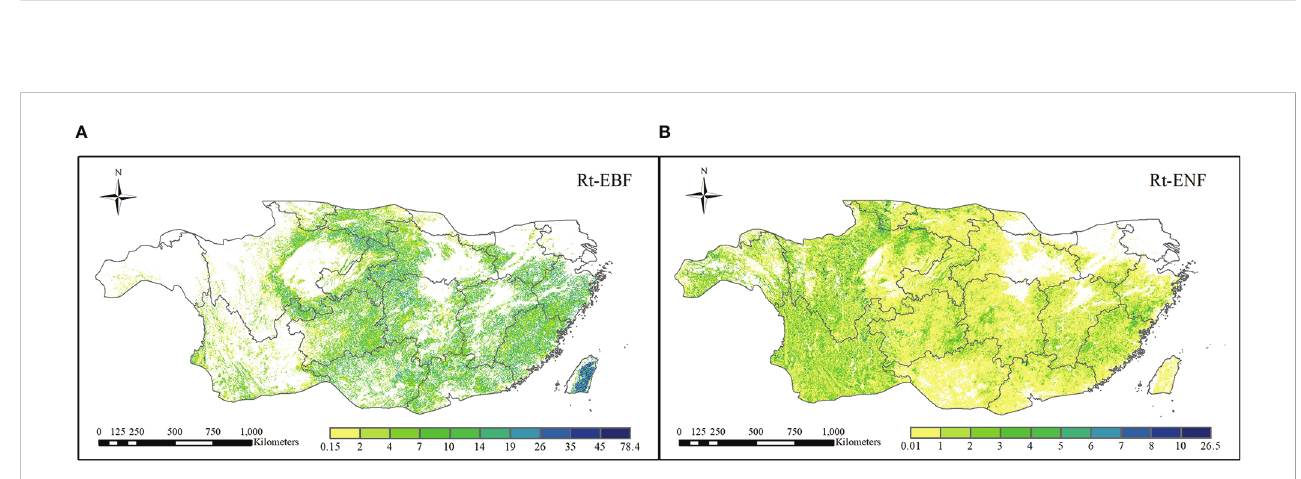
FIGURE 8 Spatial distribution of resistance to 2011 drought (A) . EBF and (B) ENF).